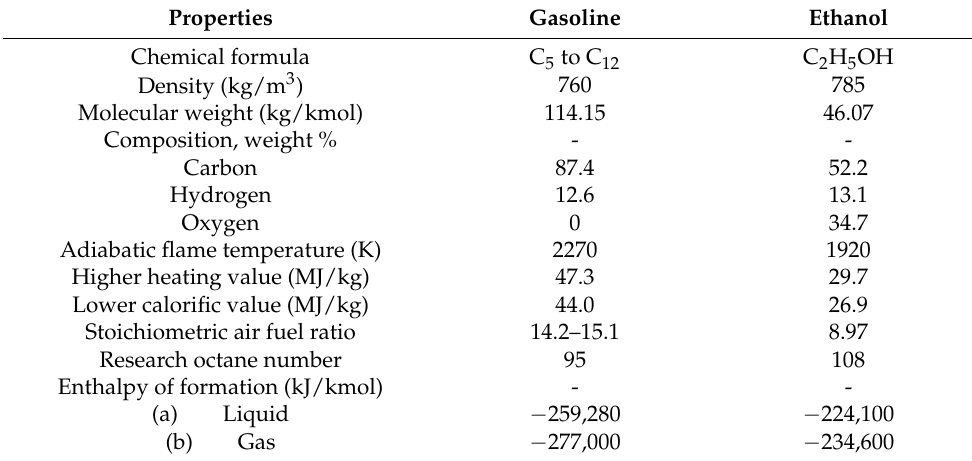
Table 2. Properties of fuels